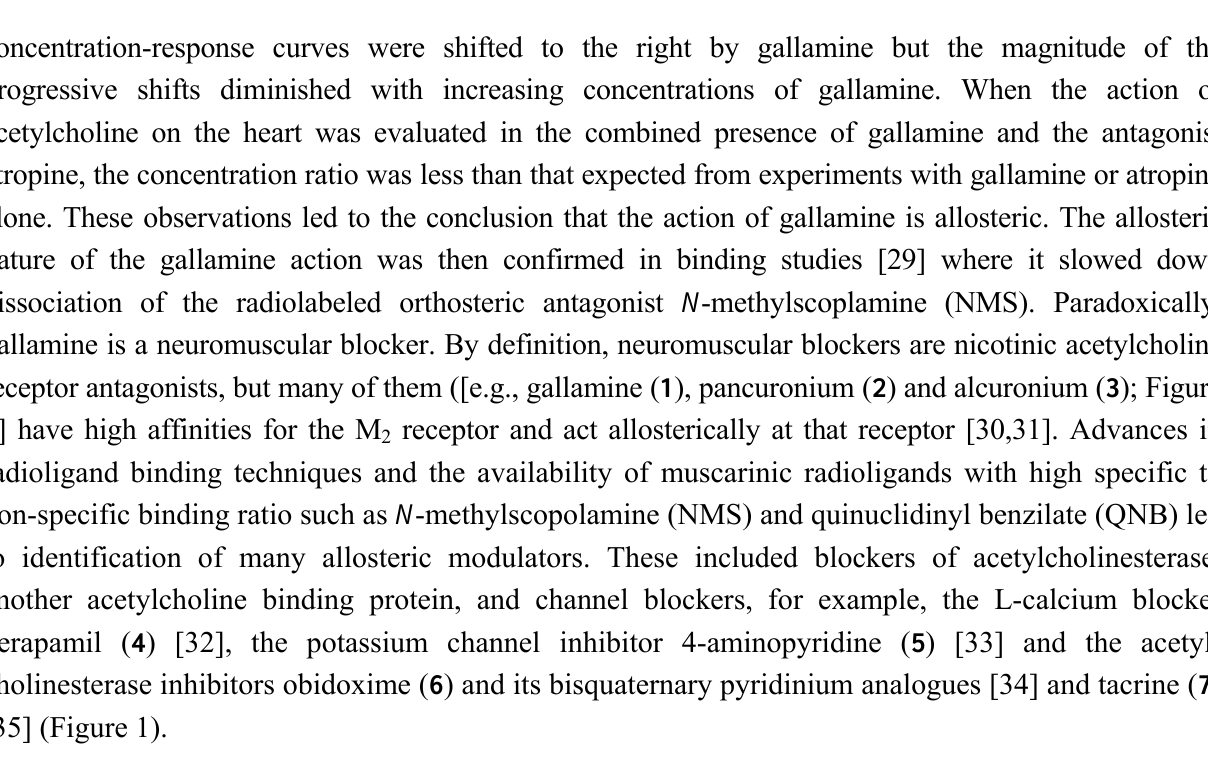
Figure 1. Structures of prototypical allosteric modulators of muscarinic